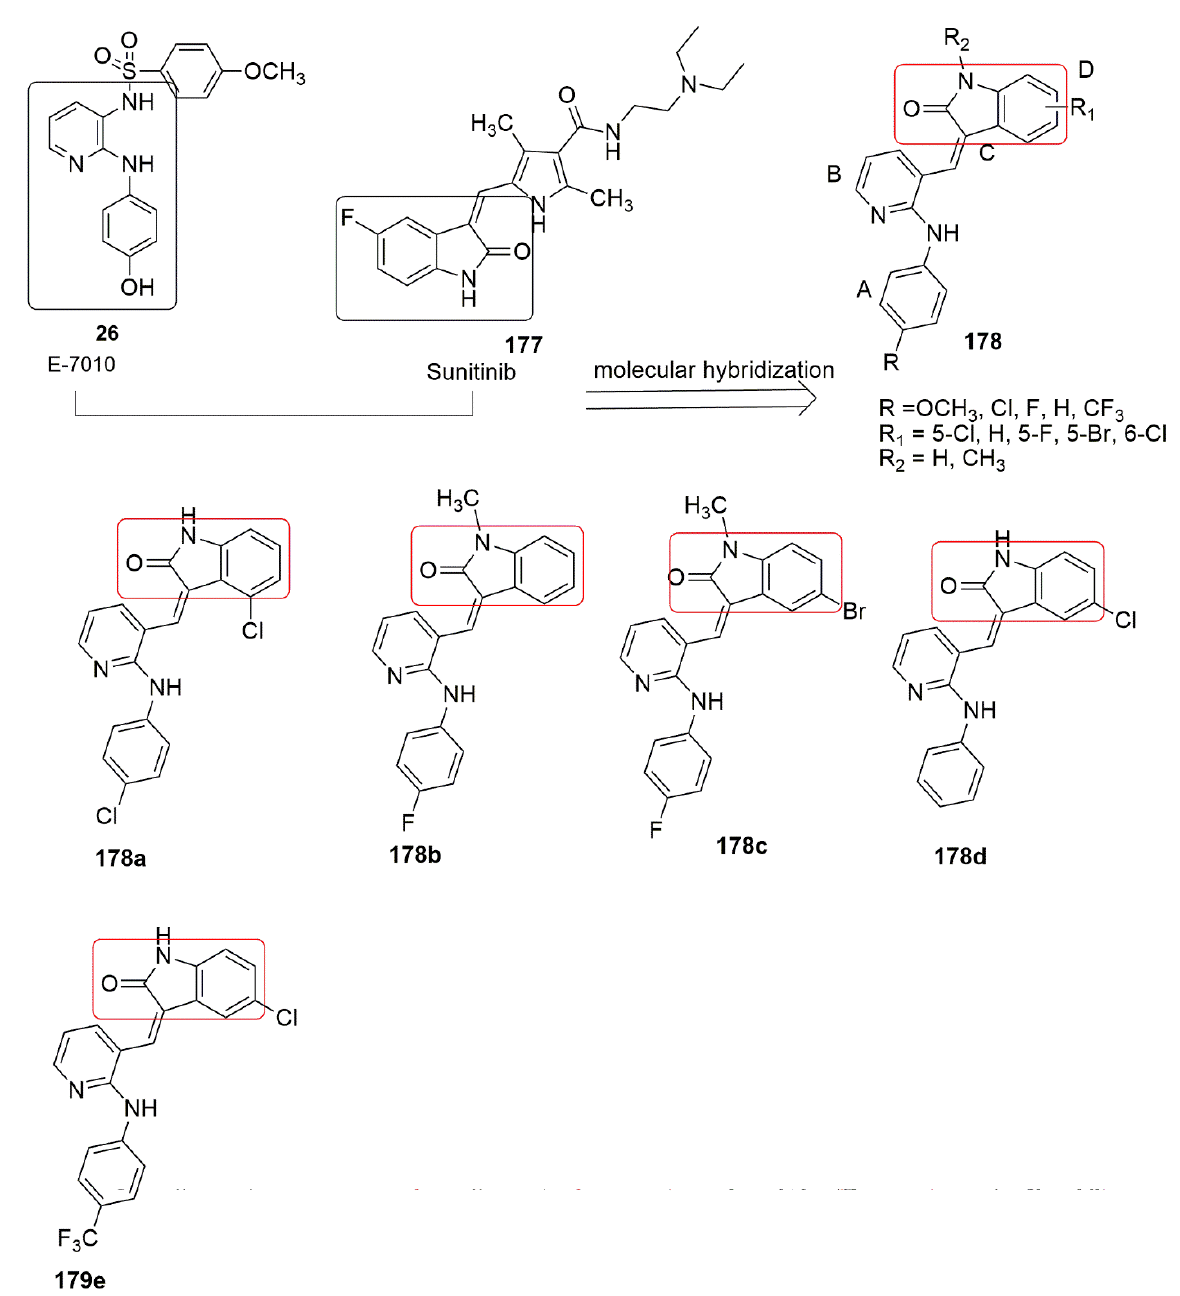
Figure 47. Chemical structures of anilinopyridyl-oxindole hybrids evaluated against a panel of four human cancer cell lines.